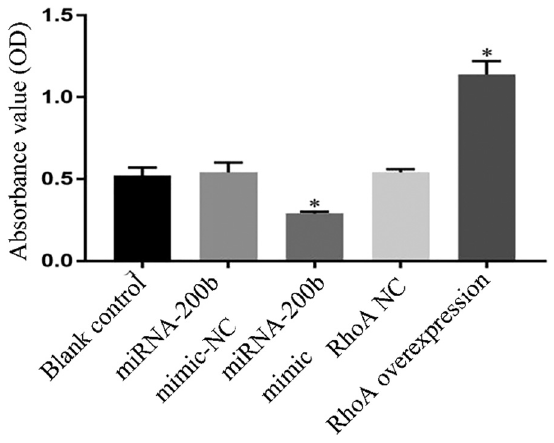
Figure 4: Comparison of proliferation ability after transfection in each group. Note: compared with blank control group and mimic - NC group, * P < 0.05.